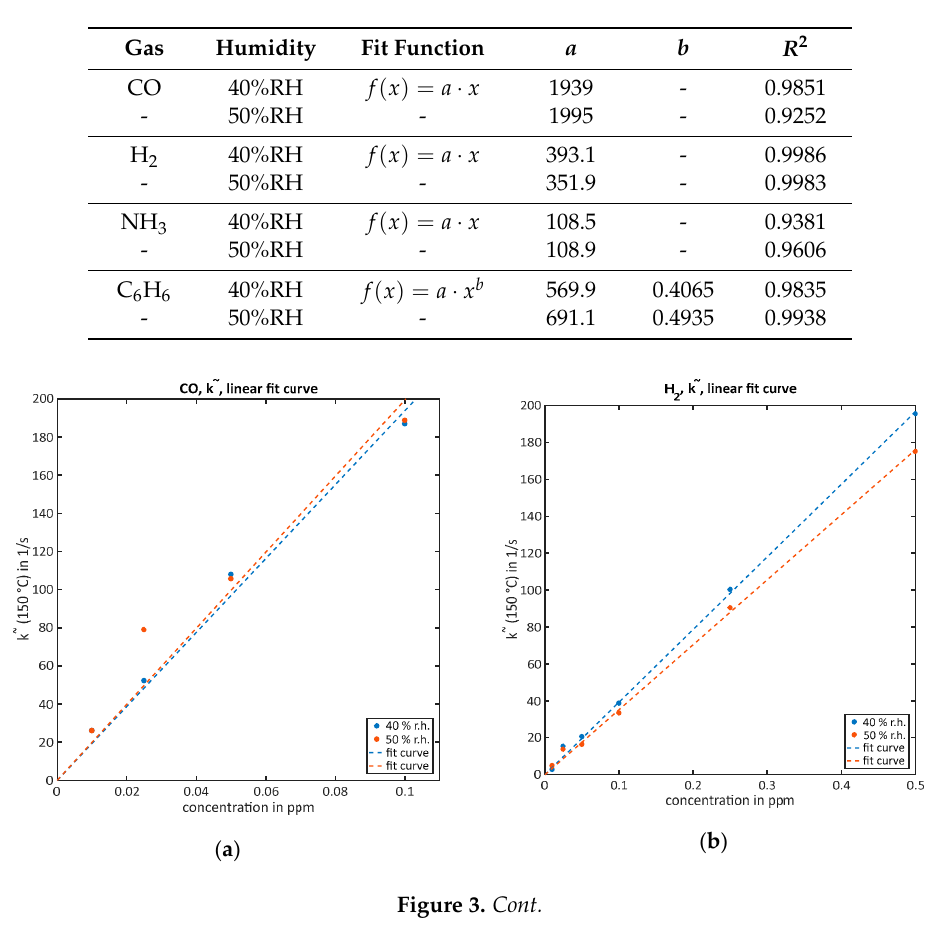
Table 2. Fitting parameters for all gases using the (cid:101) k -evaluation.